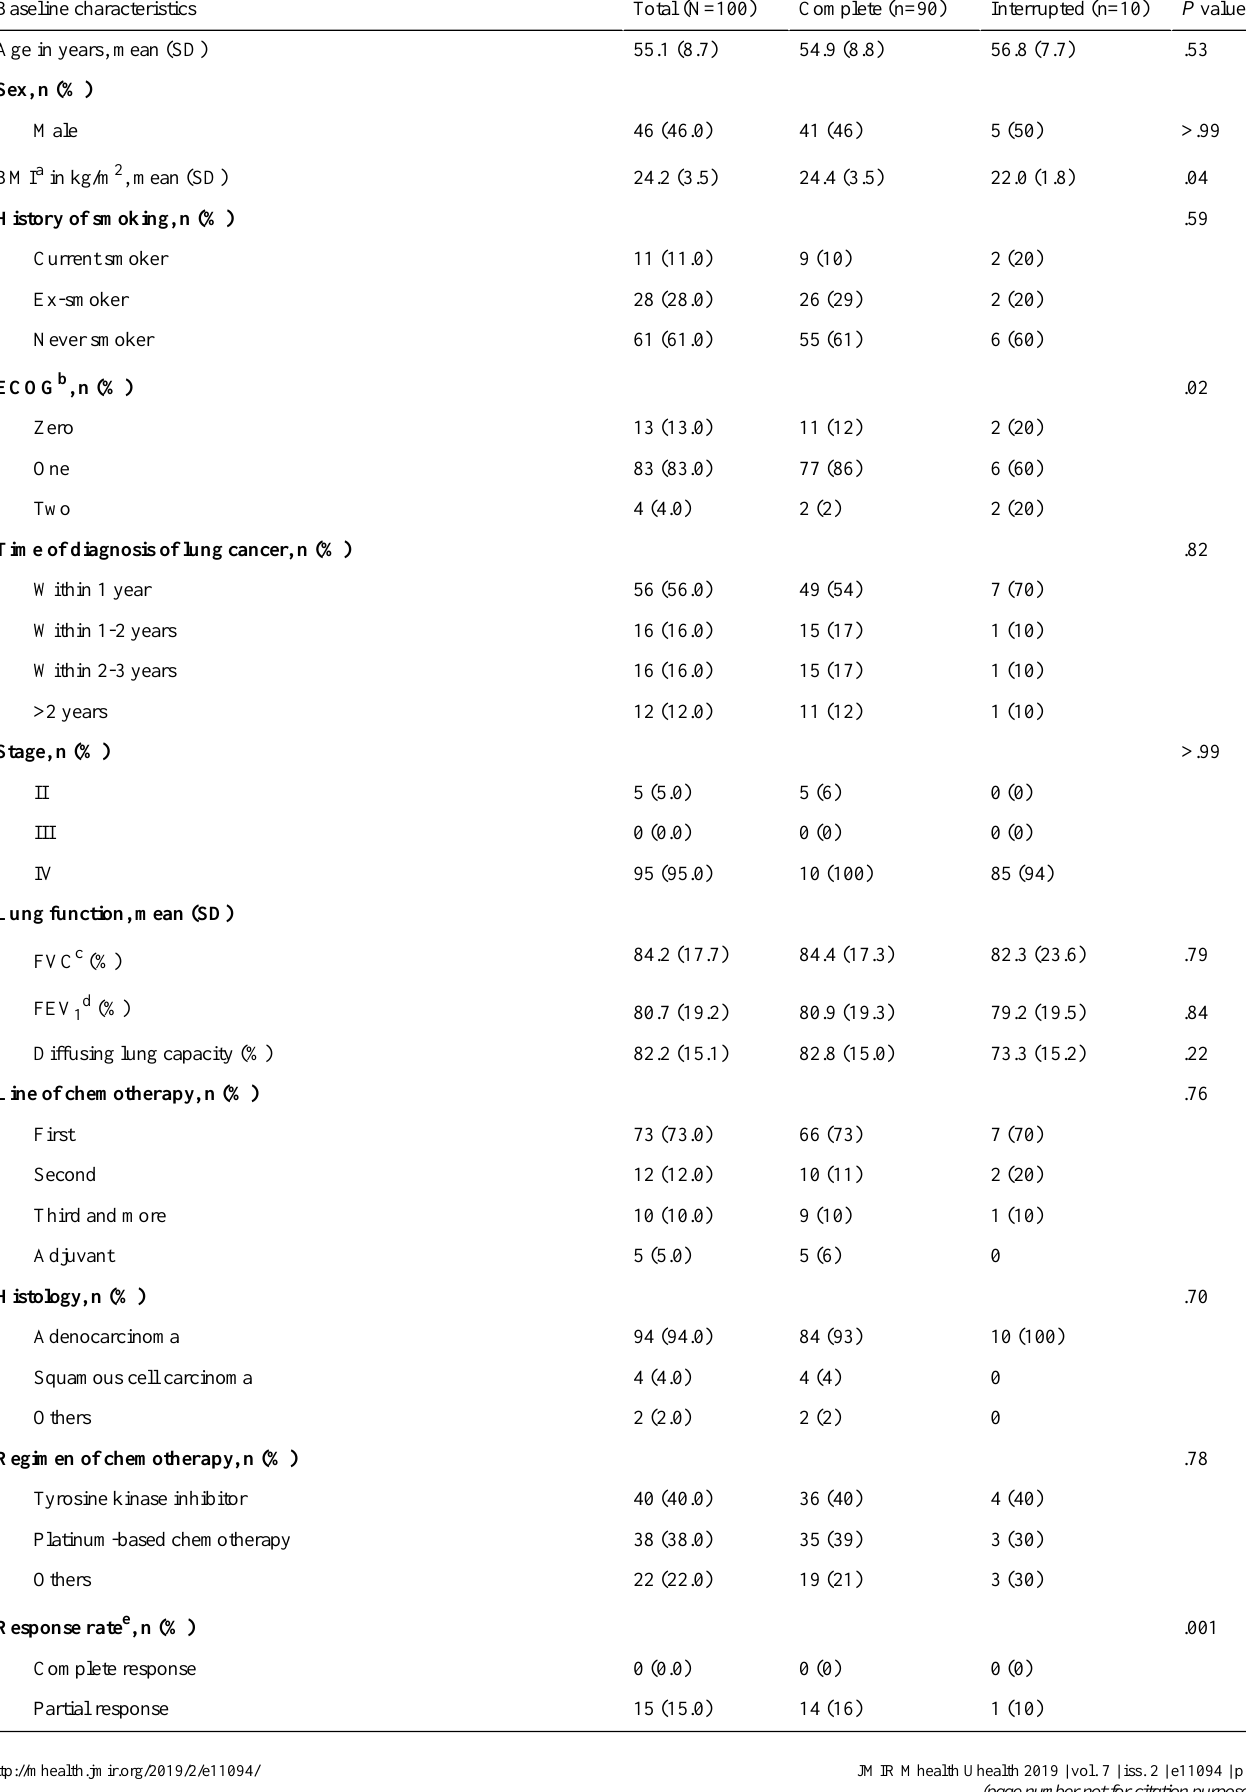
Table 2. Baseline characteristics of patients who participated in the mobile comprehensive rehabilitation